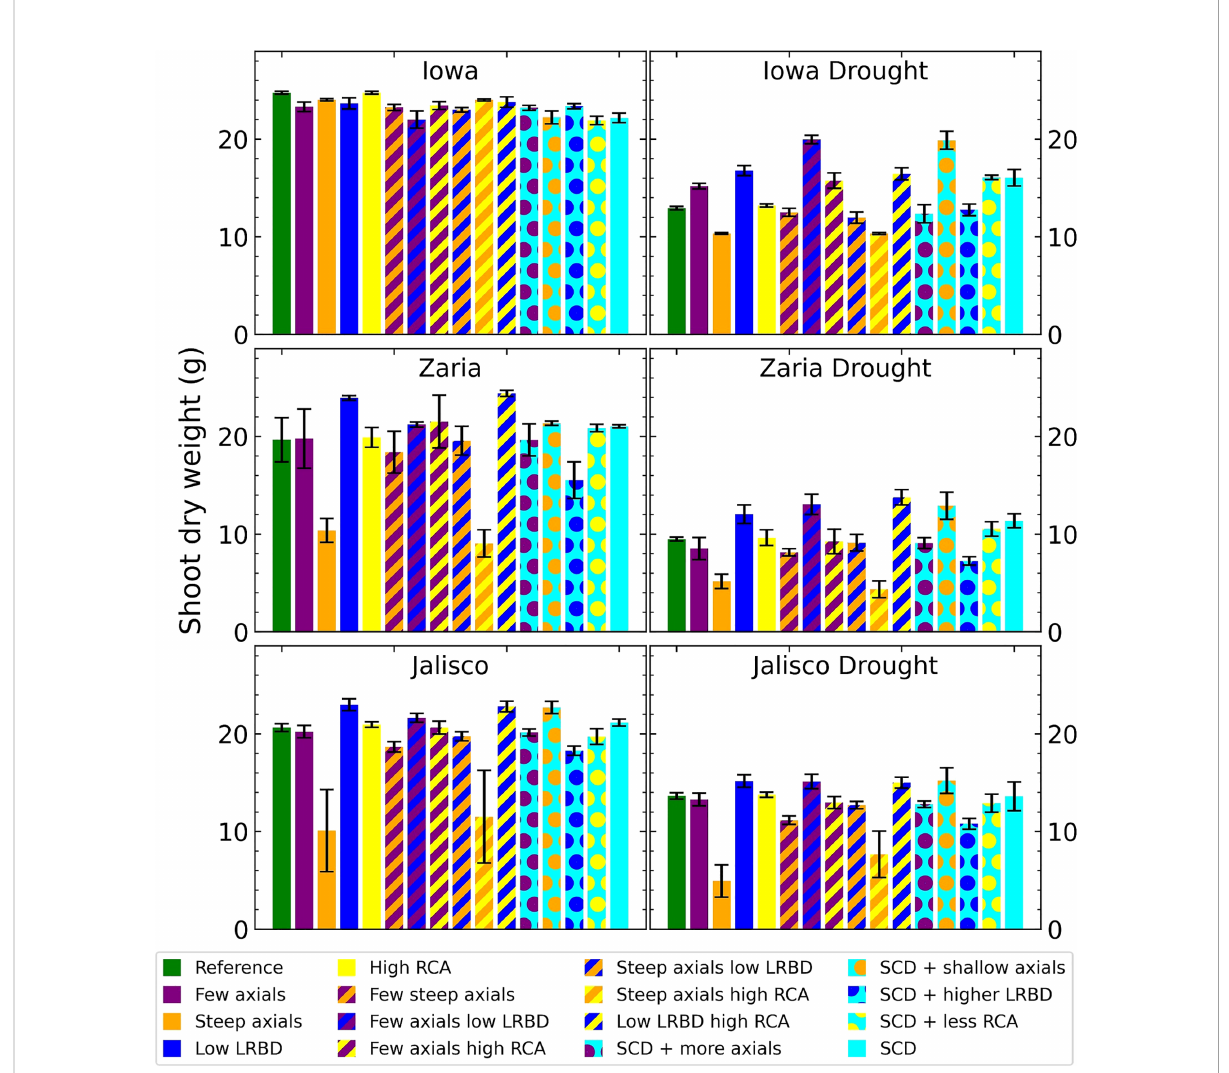
FIGURE 3 Shoot dry weight of all the maize phenotypes considered after 42 days in the 6 different environments. The error bars indicate standard deviation, n (replicates) = 5. LRBD means lateral root branching density, RCA means root cortical aerenchyma and SCD refers to the steep, cheap, deep